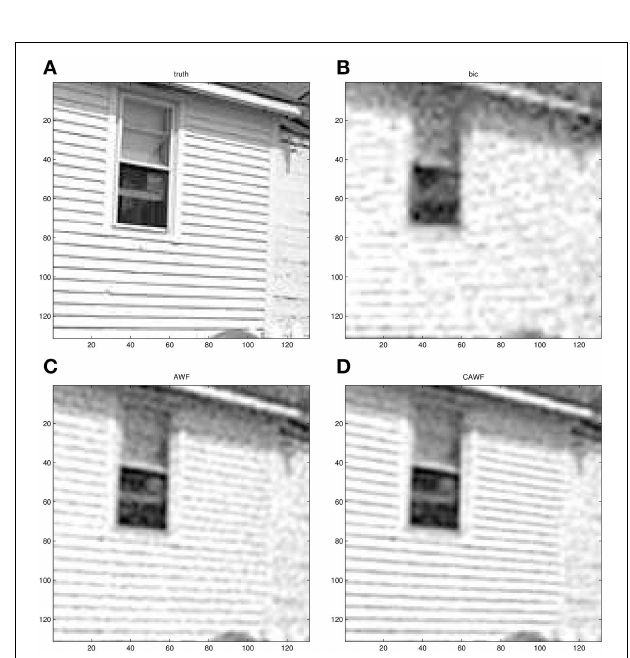
FIGURE 7 | The second Lighthouse ROI. (A) The truth image, (B) bicubic output image, (C) AWF SR output image, and (D) the CAWF output image. Processing is done using L